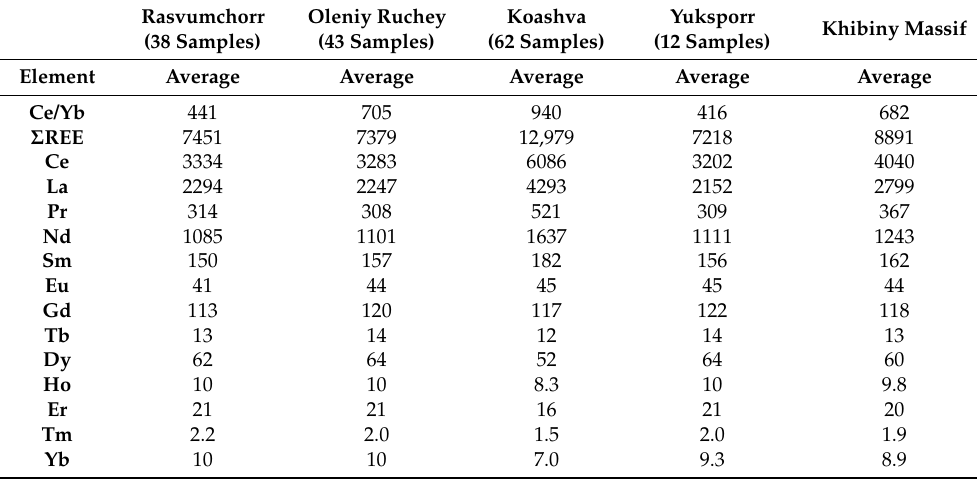
Table 2. Examples of the distribution of elements in the apatites of various fields of Khibiny massif. (1200 * analyses).